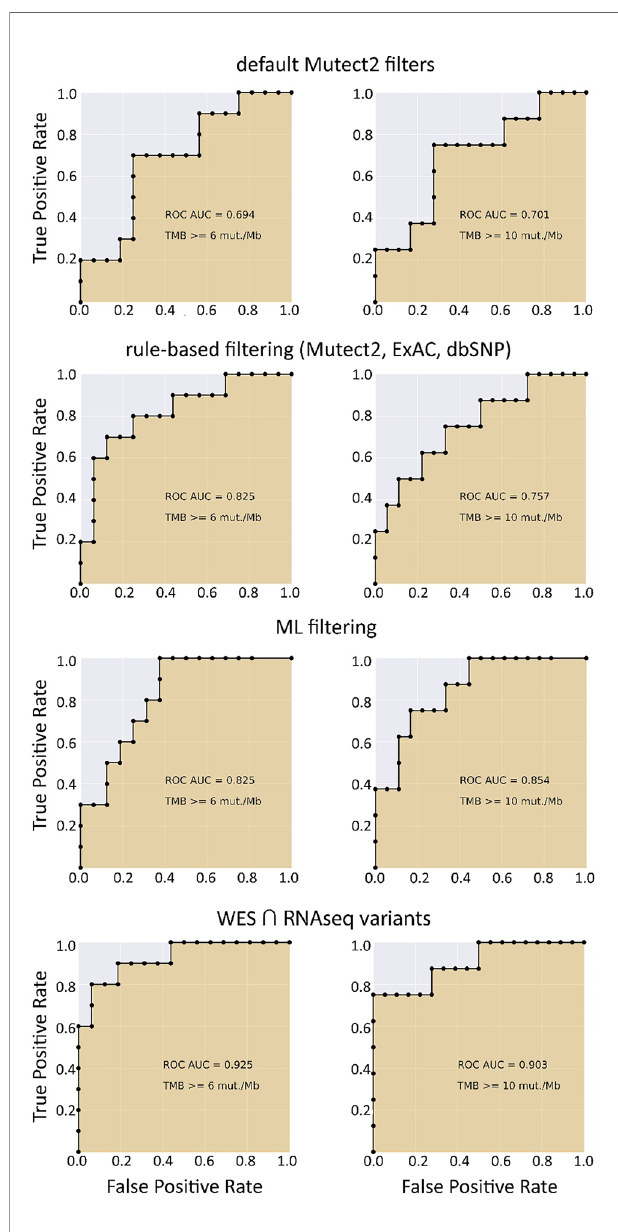
FIGURE 4 | ROC AUC scores for predicting WES-TMB per megabase with RNAseq-TMB per megabase (TCGA FFPE dataset, n =